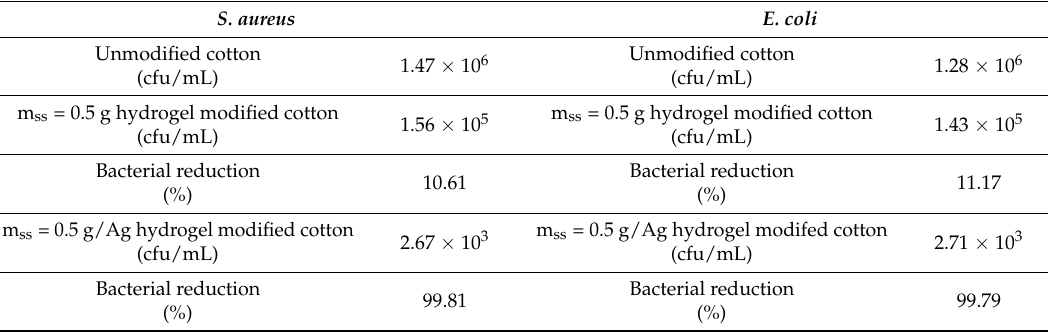
Table 3. Bacterial reductions of the IPN hydrogel modified